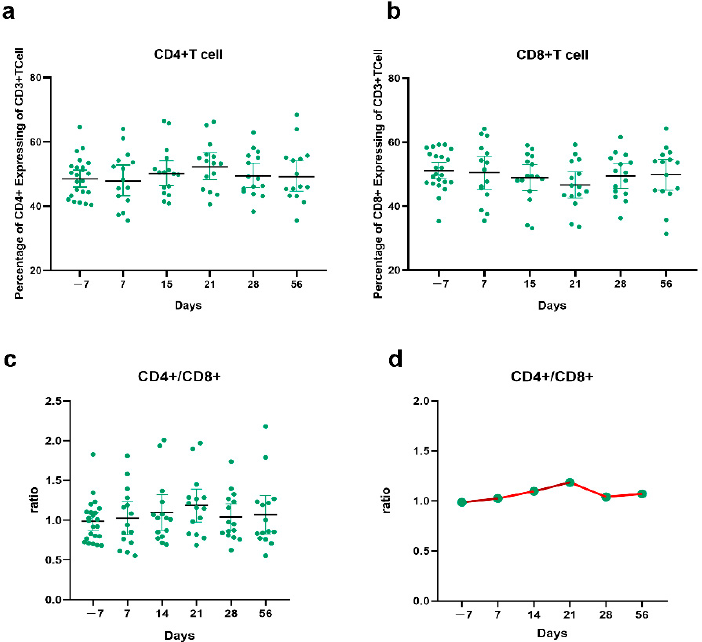
Figure 6. The trend of CD4+, CD8+ T cells responses to SARS-CoV-2 vaccination. ( a ) A CD4+ trend chart of the six time points before and after vaccination; ( b ). A CD8+ trend chart of the six time points before and after vaccination; ( c , d ) A CD4+/CD8+ trend chart of the six time points before and after vaccination.